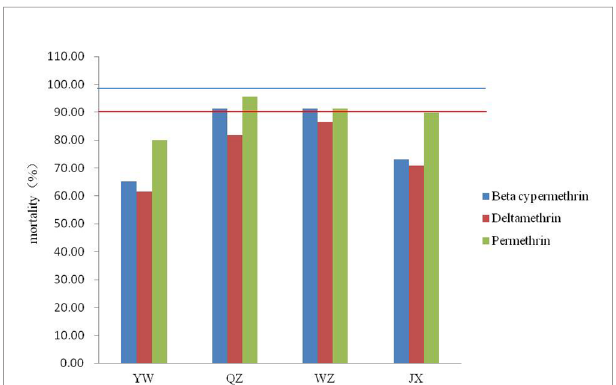
FIGURE 2 | Mortality of four Ae. albopictus fi eld populations after exposure to three pyrethroids using the WHO tube bioassay. Red lines represent 90% mortality and blue lines represent 98%